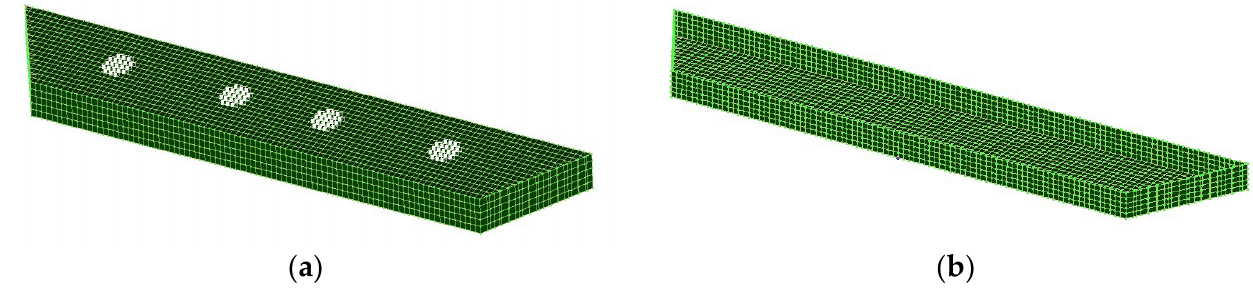
Figure 4. Numerical simulation model. ( a ) Structural model. ( b ) Hydrodynamic model.